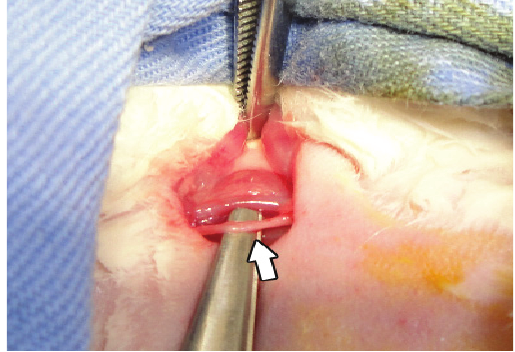
FIGURE 1 - Individualization of the right cervical sympathetic nerve (arrow).